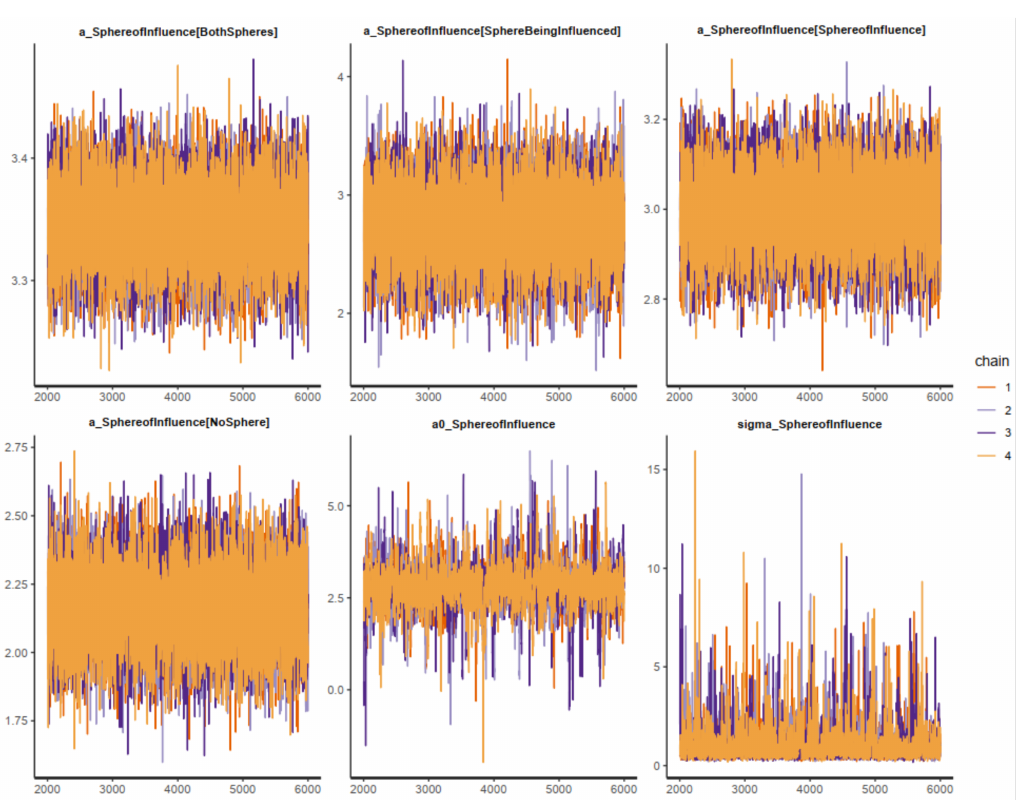
Figure A13. Model 5 (cid:48) s trace